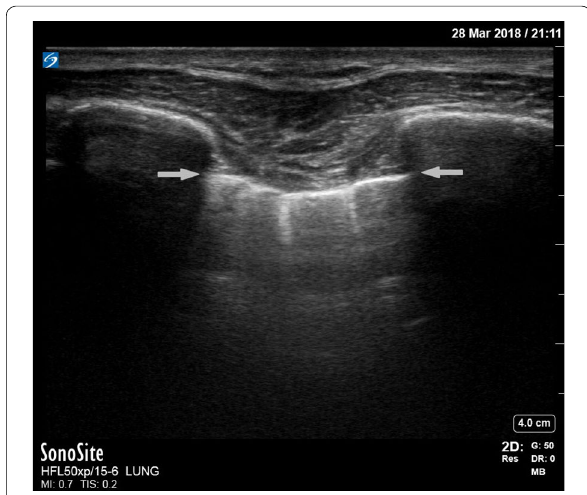
Fig. 1 Normal lung. A normal lung ultrasound image acquired with a 15–6 MHz linear transducer. The ribs are visible with their anechoic shadows on both sides of the image. The pleural line is shown in between the ribs, indicated with two horizontal arrows. Emanating down from the pleural line are comet tails. B‑lines (not visible here) also start at the pleural line, but extend all the way down to edge of the image